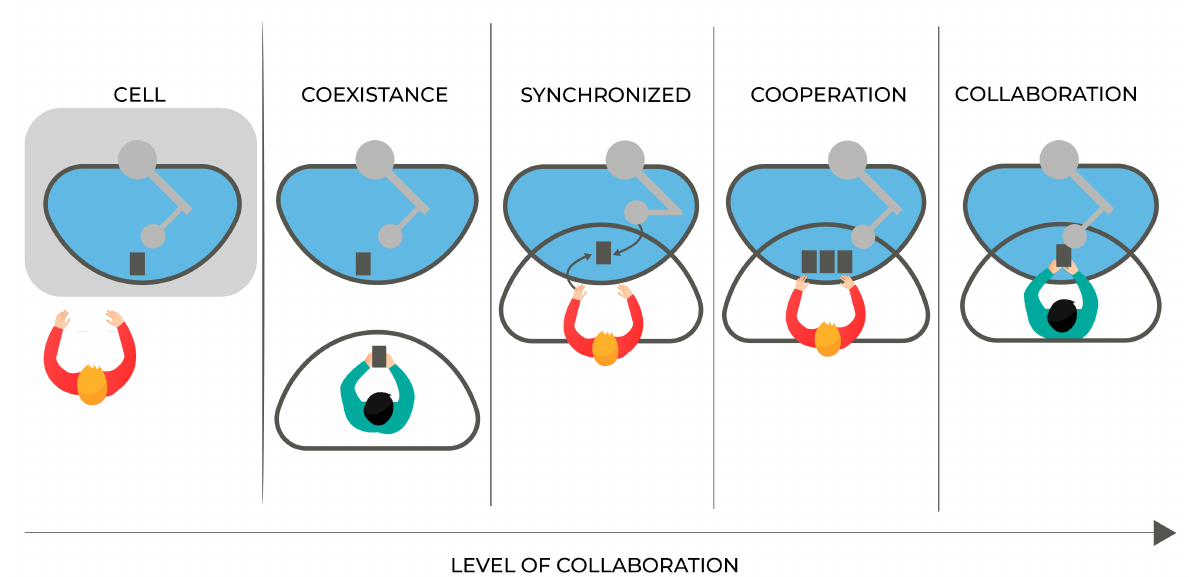
Figure 2. Levels of